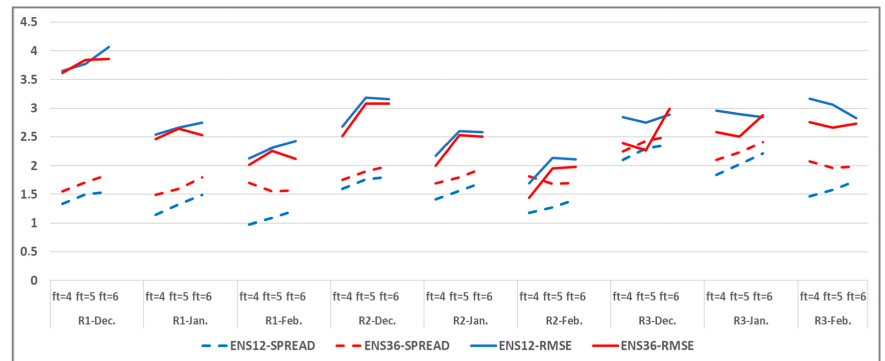
Figure 7. RMSEs of ENS12 (blue lines) and ENS36 (red lines), and ensemble spreads for ENS12 (blue dashed lines) and ENS36 (red dashed lines) at forecast times (ft) of four, five, and six months for the di ff erent subclimate regions (R1, R2, R3) and di ff erent target months (December, January, February). The unit is ◦